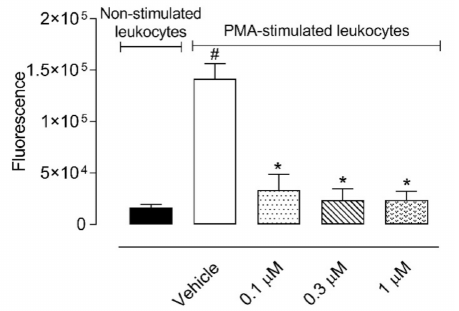
Figure 6. C 18 -5HT presented an antioxidant effect reducing reactive oxygen species (ROS) production. Leukocytes obtained after carrageenan injection into the subcutaneous air pouch were used ex vivo. Cells were activated with PMA and further incubated with vehicle or C 18 -5HT (0.1, 0.3, or 1 µ M). Fluorescence intensity was measured using DCF-DA. Results are expressed as mean ± S.D. of fluorescence intensity. The statistical significance was calculated by ANOVA followed Newman’s post-test. # p < 0.01 when comparing PMA-stimulated leukocytes incubated with vehicle with non- stimulated leukocytes and * p < 0.05 when comparing PMA-stimulated leukocytes incubated with C 18 -5HT with PMA-stimulated